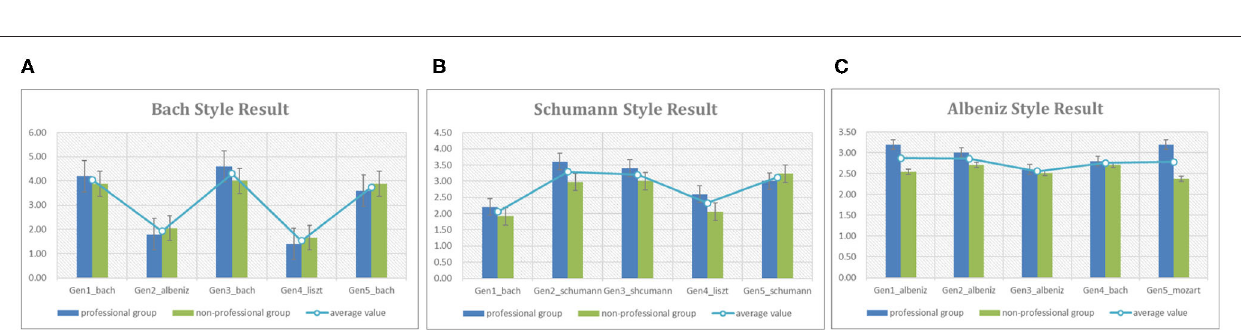
FIGURE 15 | The statistical results of composer-based composition, (A) shows the results given by professional (blue bars) and non-professional (green bars) groups on whether the melody have the Bach’s style, (B,C) exhibit the results of Schumann and